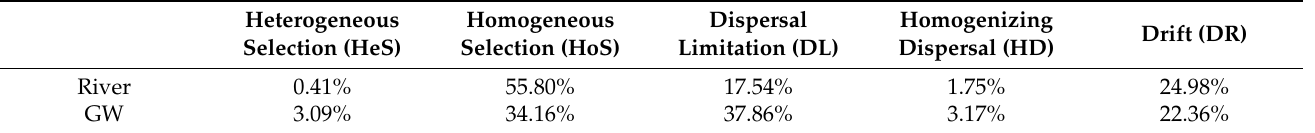
Table 3. Proportions as percentages of community assembly processes in groundwater and the